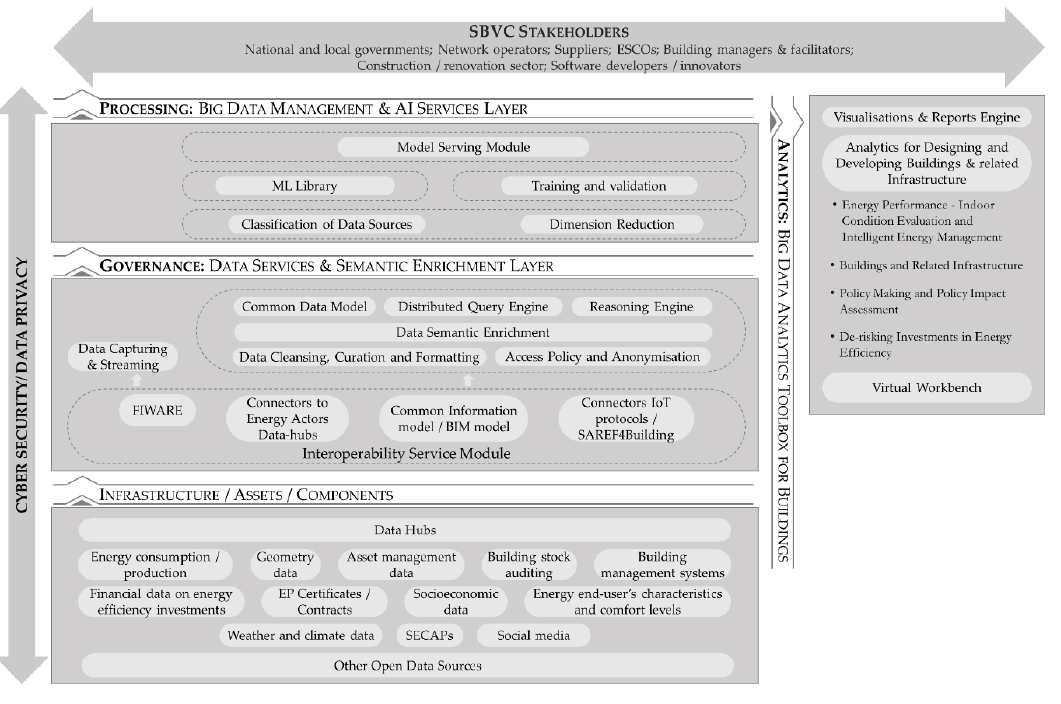
Figure 1. High-level data-driven architecture for buildings.